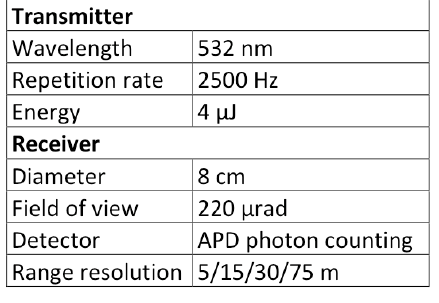
Table 1. Mini-MPL